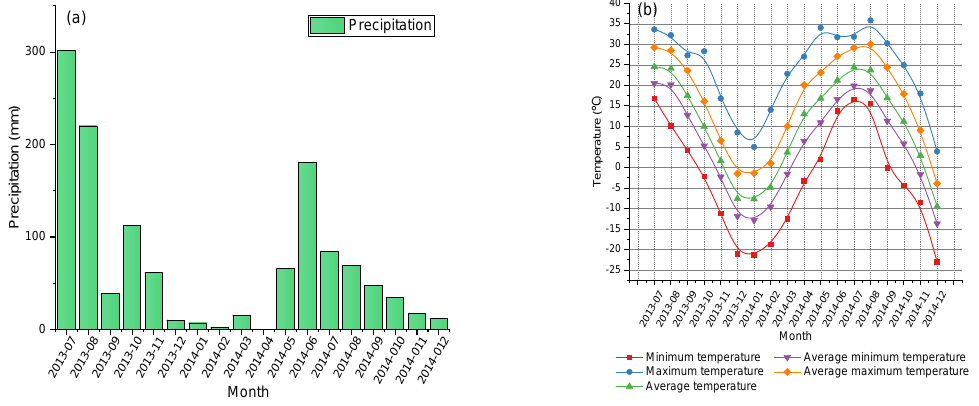
Figure 7. Distribution of precipitation and temperature: ( a ) monthly precipitation from July 2013 to December 2014; ( b ) monthly temperature from July 2013 to December 2014.